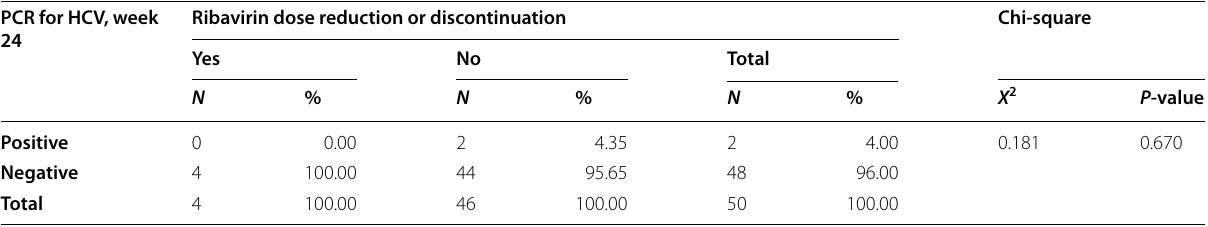
Table 4 Correlation between ribavirin dose reduction or discontinuation and PCR for HCV week 24 (SVR rate) PCR for HCV, week 24